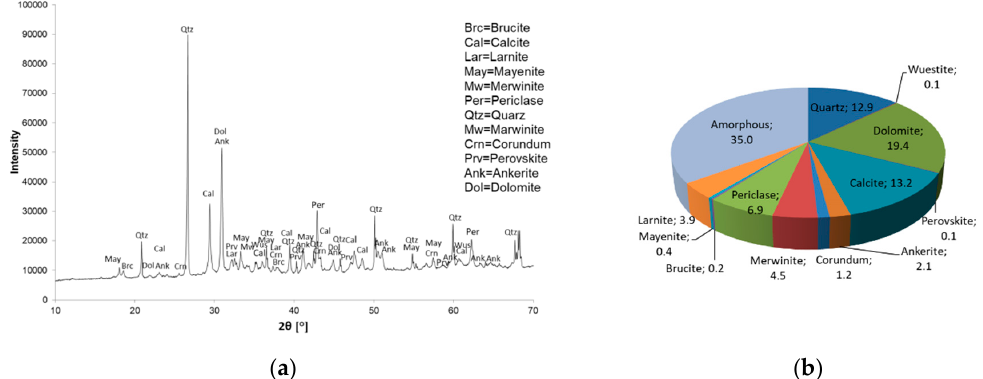
Figure 2. Powder X-Ray di ff ractogram of Slag R ( a ) and Rietveld quantification (all in %) of the phases in Slag R ( b